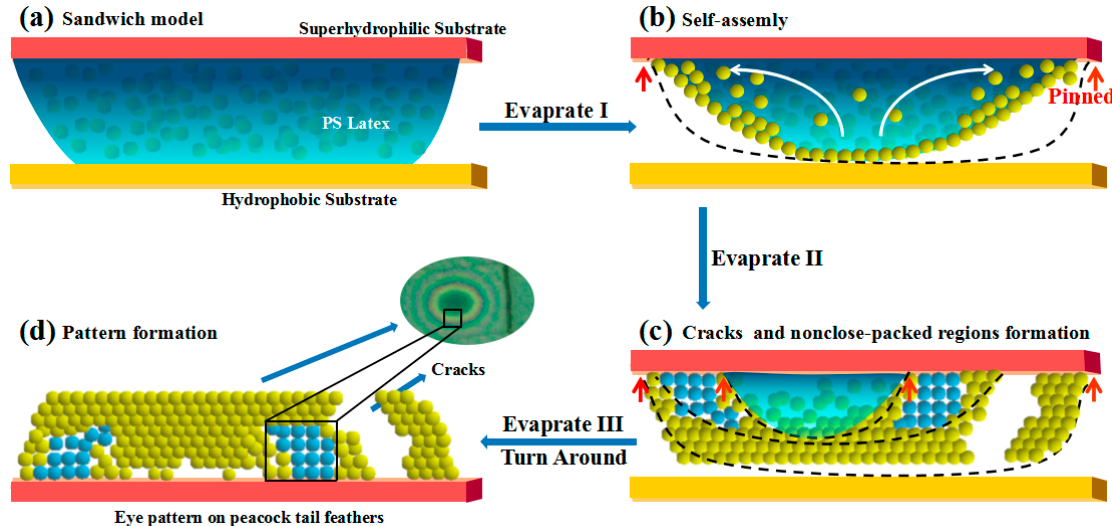
Scheme 1. Schematic illustration for the general strategy to self-assembly of PCs with eye pattern similar to the peacock tail feather. ( a ) Carefully dropping poly(styrene-methyl methacrylate-arylic acid) (Poly(St-MMA-AA)) latex onto the bottom glass and covered by the hydrophilic glass substrate, forming a sandwich assembly; ( b ) As solvent evaporating, latex assembly at the interface of gas-liquid; ( c ) The orderly arrangement (yellow particles) and disclose-packed regions (blue particles) assembled and forming cracks; ( d ) After removal of the bottom glass, the PCs with eye pattern of the peacock tail feathers can be generated. Black curves in ( b ) and ( c ) are receding three phase contact line (TCL).